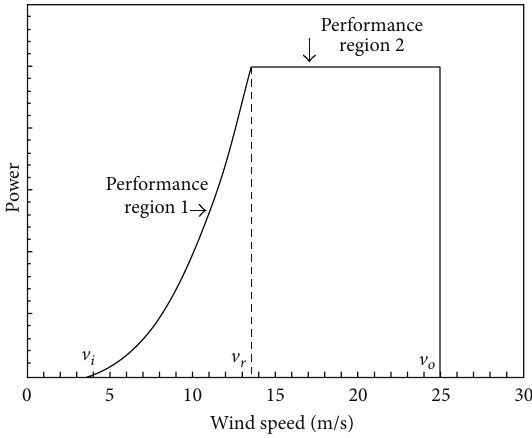
Figure 2: Typical power curve of a sample pitch controlled wind